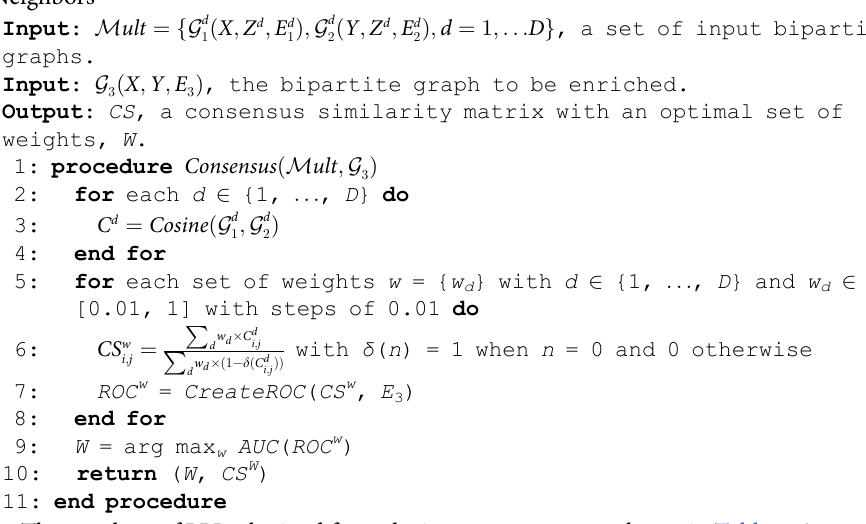
Algorithm 1 Calculating a Consensus Similarity Matrix from Multiple Sources of Common Neighbors